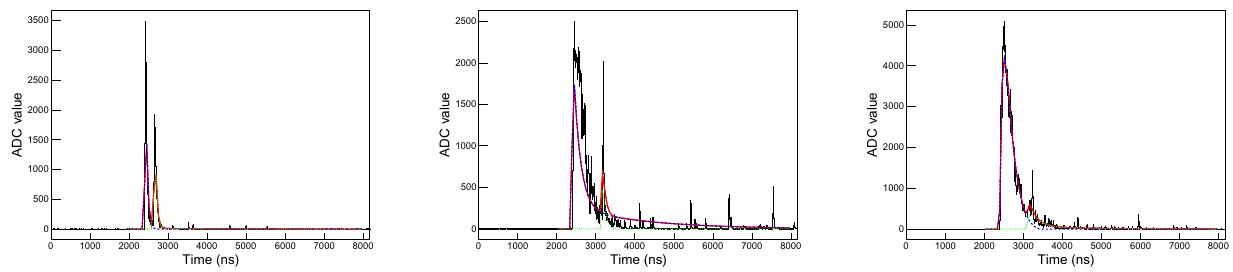
Fig. 4 Examples of two-pulse candidate events that are categorized as noisy events